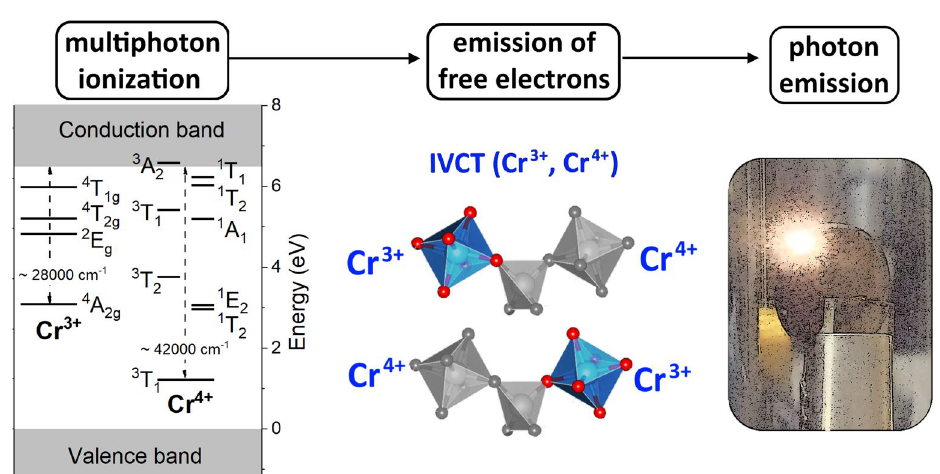
Figure 4. Schematic illustration of the mechanism responsible for LIWE from the transparent Cr 4+ :YAG